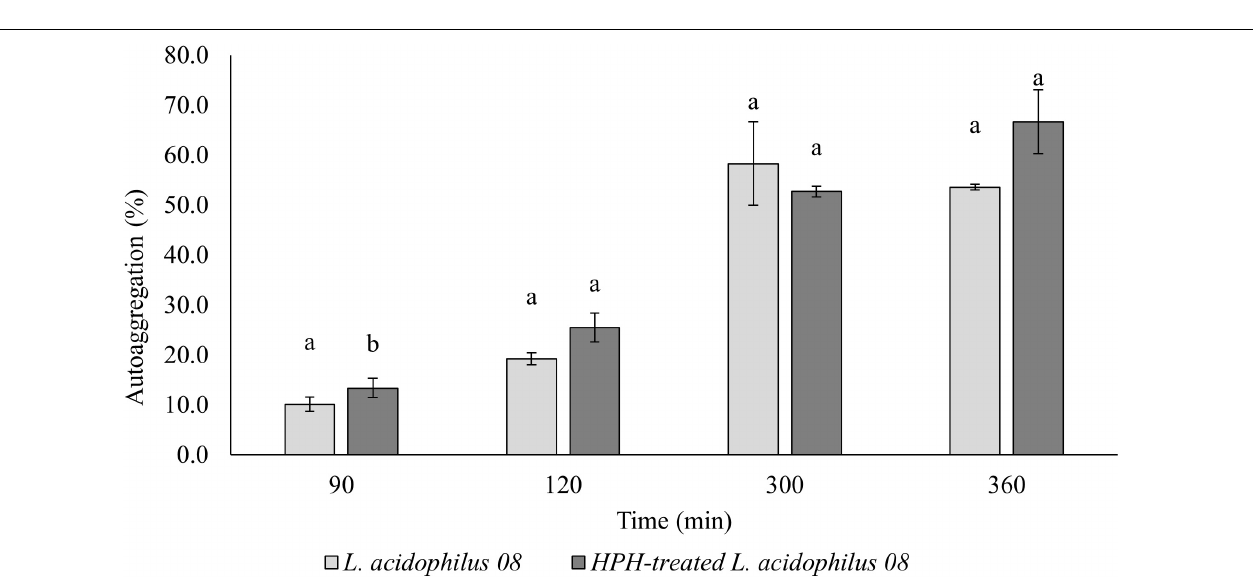
FIGURE 2 | Lactobacillus acidophilus 08 percentage adhesion values of the untreated (control) and treated (HPH at 50 MPa) cells over time (60–120 min). Relative adhesion was calculated on the base of CFU/mL before and after the adhesion assay. The results are the average of four independent replicates ( n = 4). Error bars indicate the SD. Different lowercase letters indicate the significant differences ( t -test; p < 0.05) for a considered sample during the frame time considered (120 min).